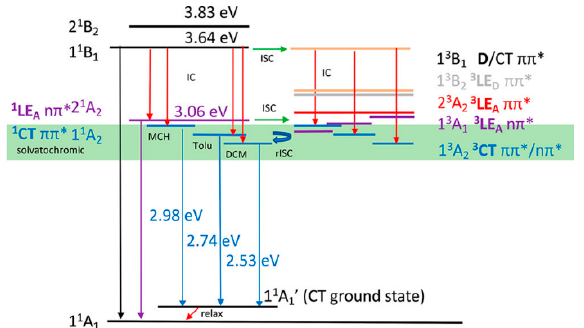
Figure 30. Measured energy levels from spectral onsets of 109 in solvents of different polarity. The green band represents the energy range over which solvatochromic states were observed. Red arrows represent nonradiative transitions. Adapted with permission from [89], Copyright 2021, American Chemical Society, https://pubs.acs.org/doi/10.1021/acs.jpclett.0c03314 (accessed on 8 July 2021). Further permissions related to the material excerpted should be directed to the American Chemical Society.